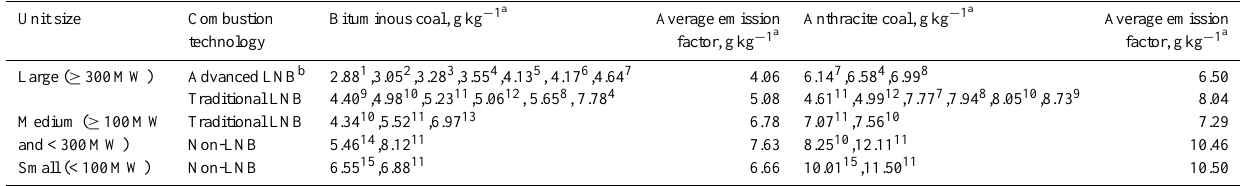
Table 1. Summary of NO x emission factors for different types of coal-fired power plants. Unit size